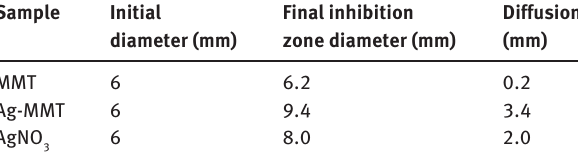
Table 1 Zone of inhibition test result.